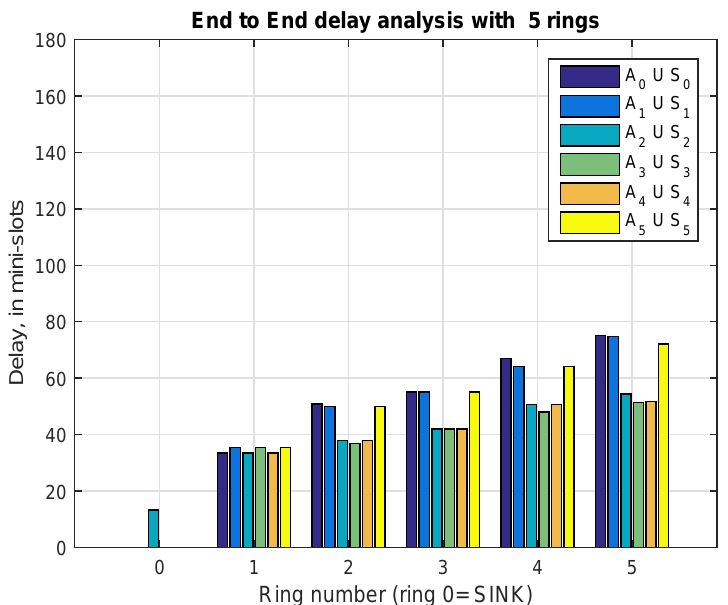
Figure 11. End to end delay (in mini-slots), from sensor to the sink, for r max = 5, p act = 0.001 and ( N ) = ( 2,3;1,7 ) . msC , N intra ; N msT , N inter